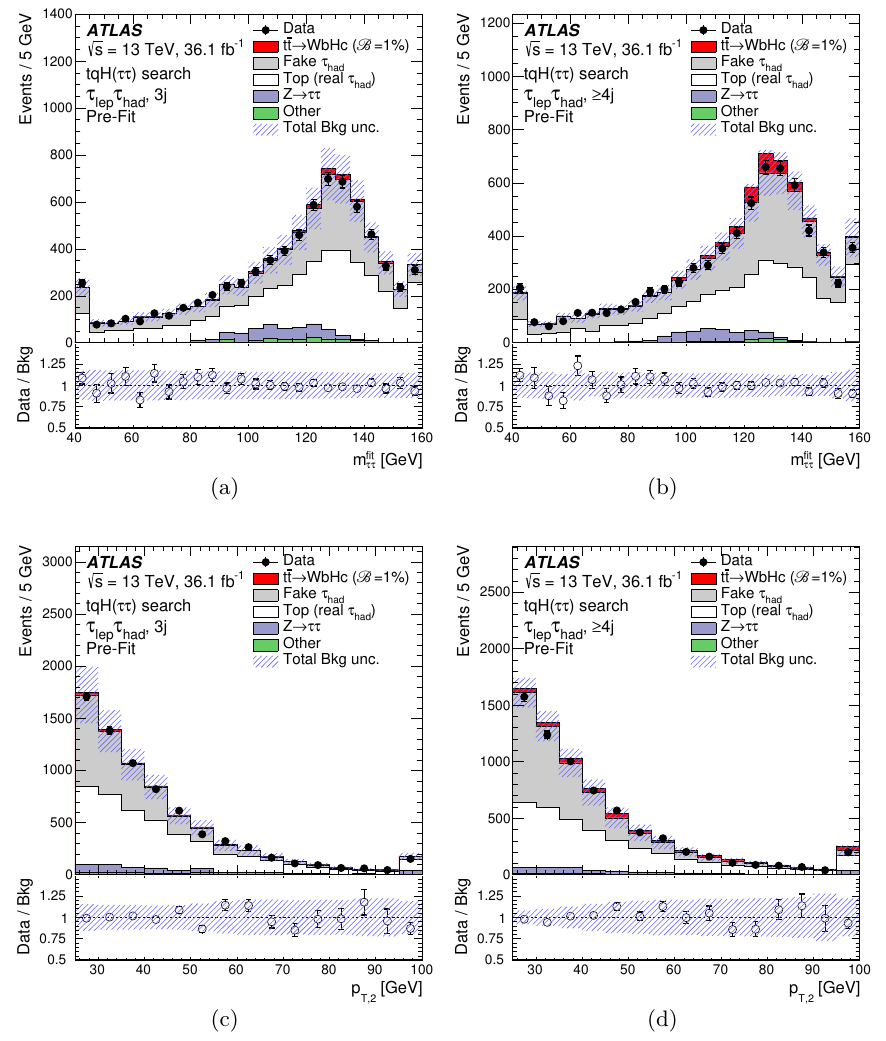
Figure 4 . tqH ( (cid:28)(cid:28) ) search: comparison between the data and predicted background after prese- lection for the distributions of two of the most discriminating BDT input variables in the (cid:28) lep (cid:28) had channel before the (cid:12)t to data (\Pre-Fit"). The distributions are shown for m (cid:12)t in (a) the ( (cid:28) lep (cid:28) had , (cid:28)(cid:28) 3j) region and (b) the ( (cid:28) lep (cid:28) had , (cid:21) 4j) region, and for p T ; 2 in (c) the ( (cid:28) lep (cid:28) had , 3j) region and (d) the ( (cid:28) lep (cid:28) had , (cid:21) 4j) region. The contributions with real (cid:28) had candidates from t (cid:22) t , t (cid:22) tV , t (cid:22) tH , and single-top- quark backgrounds are combined into a single background source referred to as \Top (real (cid:28) had )", whereas the small contributions from Z ! ‘ + ‘ (cid:0) ( ‘ = e; (cid:22) ) and diboson backgrounds are combined into \Other". The expected t (cid:22) t ! WbHc signal (solid red) corresponding to B ( t ! Hc ) = 1% is also shown, added to the background prediction. The (cid:12)rst and the last bins in all (cid:12)gures contain the under(cid:13)ow and over(cid:13)ow respectively. The bottom panel displays the ratio of data to the SM back- ground (\Bkg") prediction. The hashed area represents the total uncertainty of the background, excluding the normalisation uncertainty of the fake (cid:28) had background, which is determined via a likelihood (cid:12)t to data.